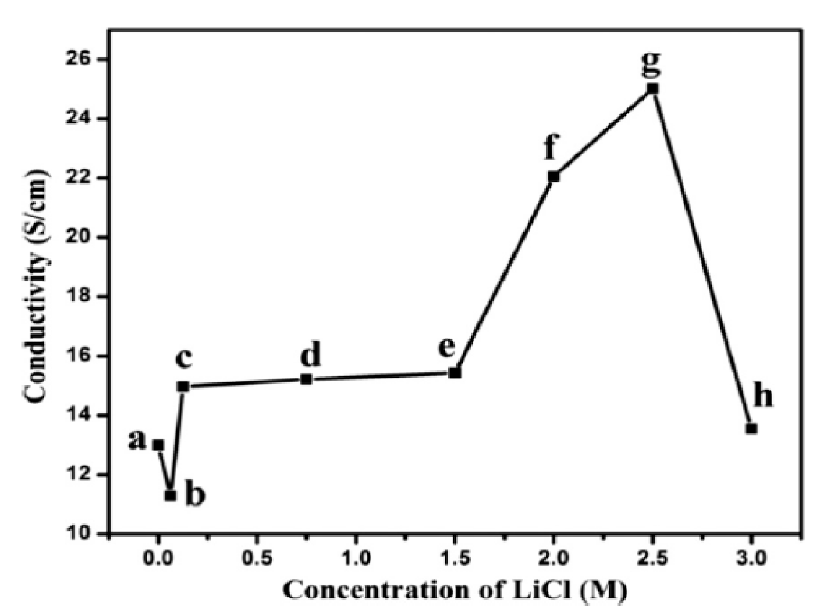
Figure 4. Electrical conductivity of PANI vs. concentration of LiCl ( a ) PANi, ( b ) PANi-LiCl (0.0625 M), ( c ) PANi-LiCl (0.125 M), ( d ) PANi-LiCl (0.75 M), ( e ) PANi-LiCl (1.5 M), ( f ) PANi-LiCl (2.0 M), ( g ) PANi- LiCl (2.5 M), and ( h ) PANi-LiCl (3.0 M)